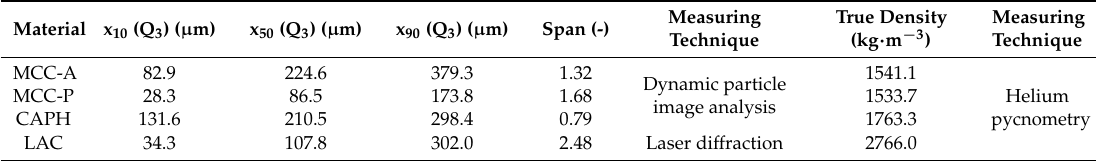
Table 1. Physical properties of the powders of interest: particle size distribution (PSD) from volumetric/mass cumulative distributions and true/skeletal density.